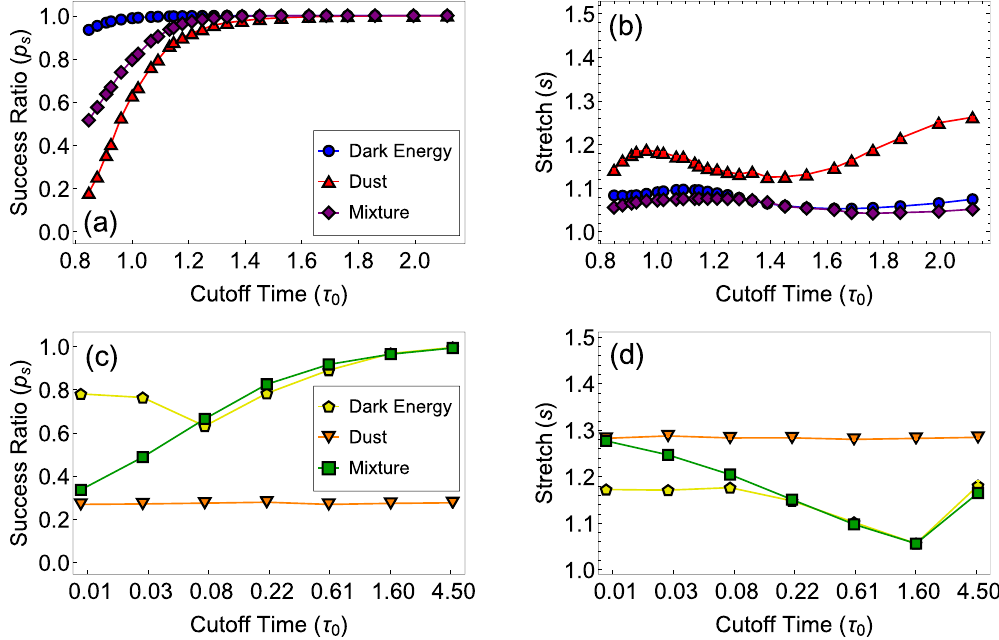
Figure 3. Navigability of random geometric graphs in the three manifolds. In ( a , b ), corresponding to graphs in panels (a,b) in Fig. 2 where the sprinkling density and spatial cutoff are held constant q = 60 and ρ 0 = 6, the success ratio increases toward 100% as the temporal cutoff increases, while the average stretch remains low and close to 1, especially for spacetimes with dark energy. In ( c , d ), the graph size and average degree are kept constant N = 2 20 and = k 10 as described in the Methods. The success ratio and stretch in this case depend only on manifold geometry. The average stretch is still low, especially for the manifolds with dark energy. However, the success ratio increases to 100% only for spacetimes with dark energy, while for the dust manifold it is a constant below 100%, which does not depend on the cutoff